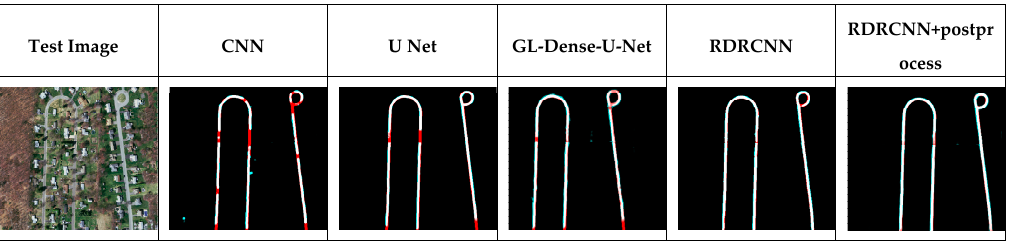
Figure 9. Cont Figure 8. Comparison of the road extraction results of four methods in different experimental areas of the Massachusetts dataset. Zoomed-in view to see more details.